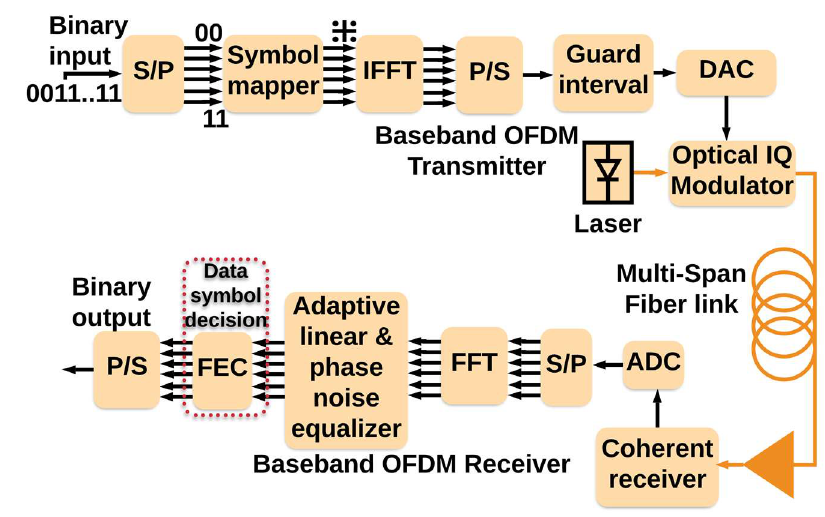
Figure 13. The conventional OFDM-based fiber optic system. (FEC: Forward error correction, P / S: Parallel to serial, DAC: Digital-to-analog converter, ADC: Analog-to-digital converter, S / P: Serial to parallel, IFFT: Inverse fast Fourier transform, FFT: Fast Fourier transform).